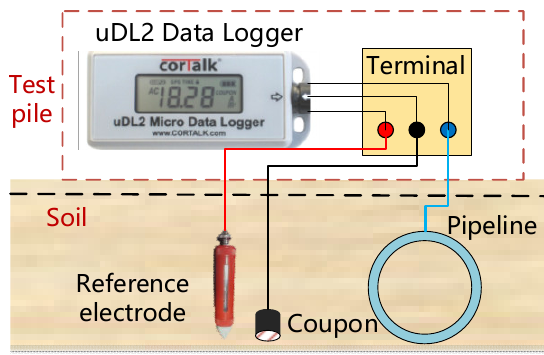
Figure 6. Test circuit based on external coupon method.